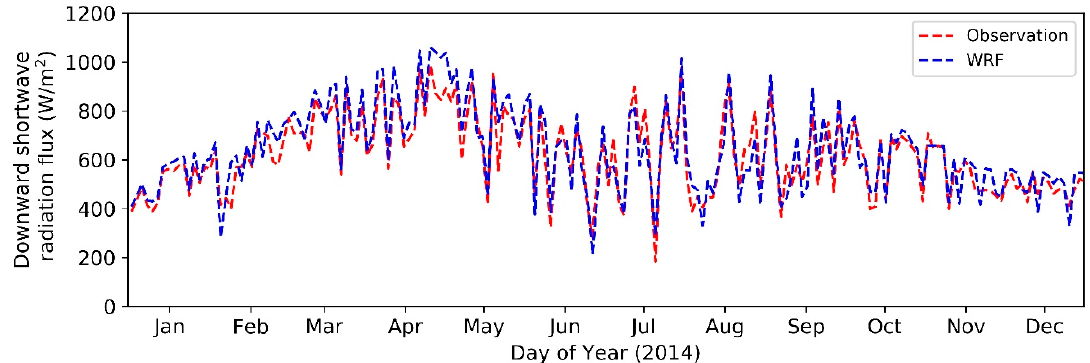
Figure 4. Comparison between the observed and Weather Research and Forecasting (WRF)-modeled downward shortwave radiation flux (DSRF) (Yakou station).